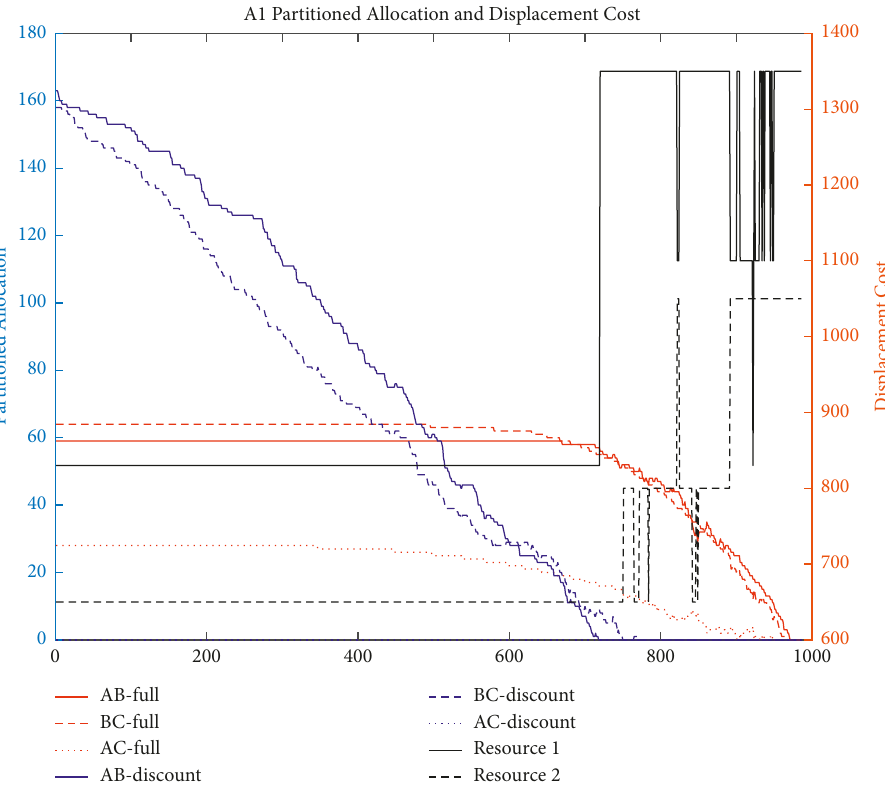
Figure 7: Partitioned allocation and displacement cost of flight